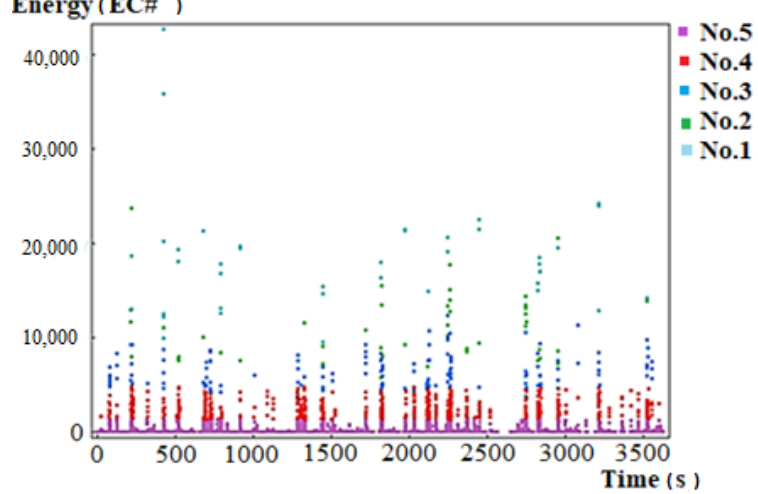
Figure 6. Energy–time relationship for the bottom chord of the truss in span 1 with the numbers of signal classes marked.